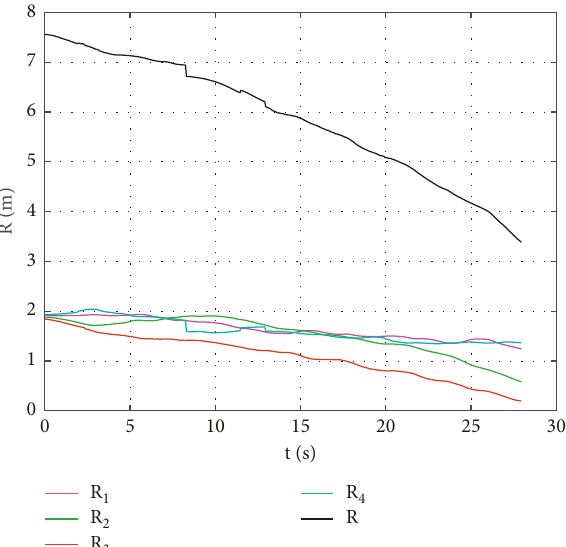
Figure 15: The changes in horizontal distance between pursuit quadrotors and escaping quadrotor ( N � 4, λ � 0 .